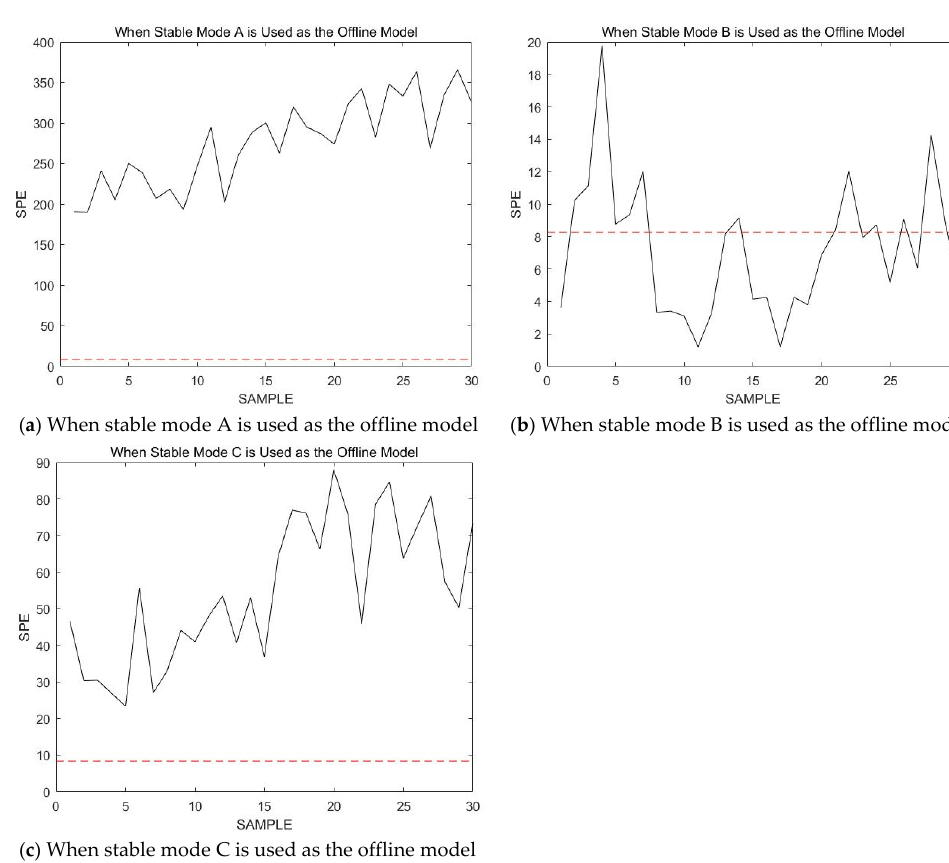
Figure 7. The obtained results in terms of the SPE statistics.